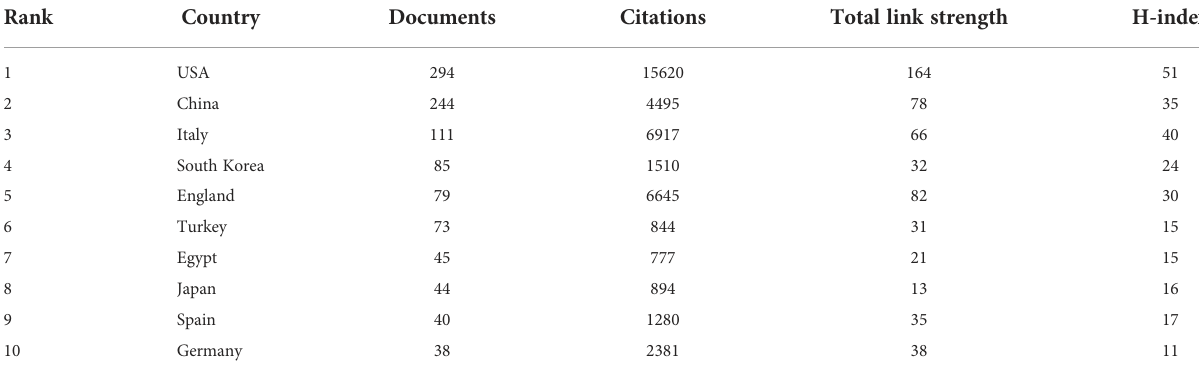
TABLE 1 The 10 countries that contributed the most to DMED-related